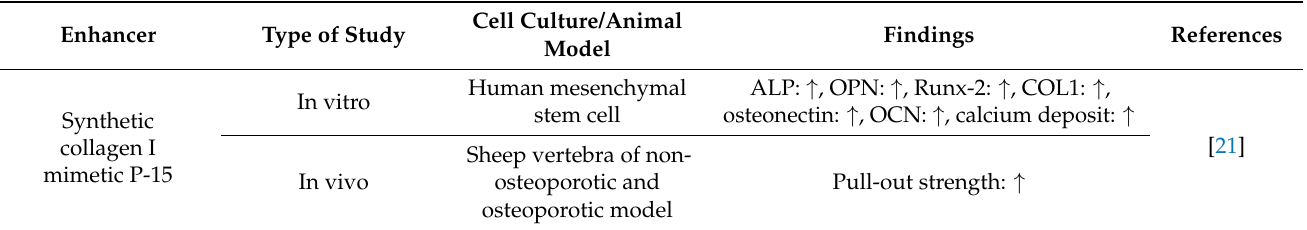
Table 2. Bone-sparing properties of CPC enhanced by biomimetic